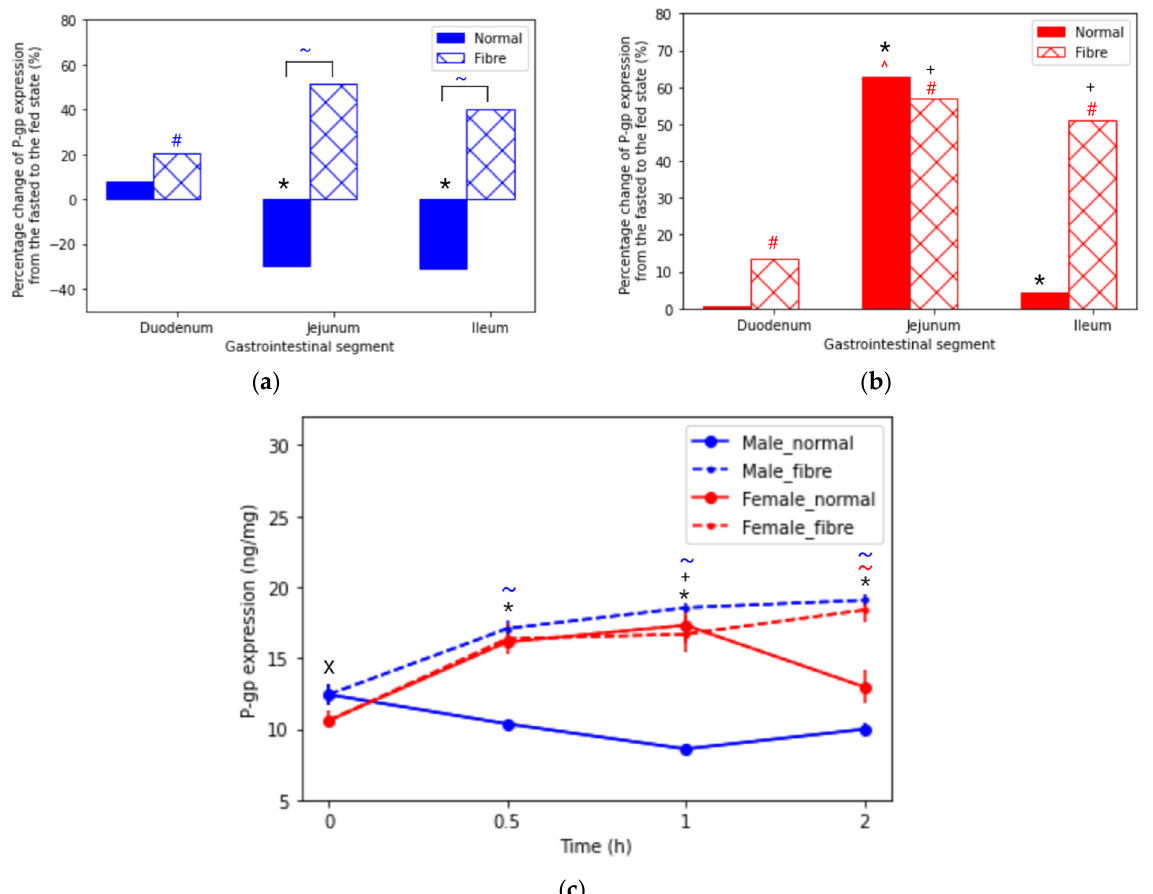
Figure 1. Percentage change in P-glycoprotein (P-gp) expression across the intestinal tract in ( a ) male and ( b ) female rats at time = 1 h from the fasted state to the fed states (normal meal and fibre meal). ( c ) P-gp expression (ng/mg) in the jejunum from time 0 to 2 h under fasted and fed states (normal meal and fibre meal) (mean ± SD) ( n = 6). The following symbols denote a statistical significance ( p < 0.05) showing a sex difference between male and female rats: fasted state (X), normal meal (*) and fibre meal (+); and a food effect between the feeding interventions: fasted and fibre (#), fasted and normal (^) and normal and fibre (~).